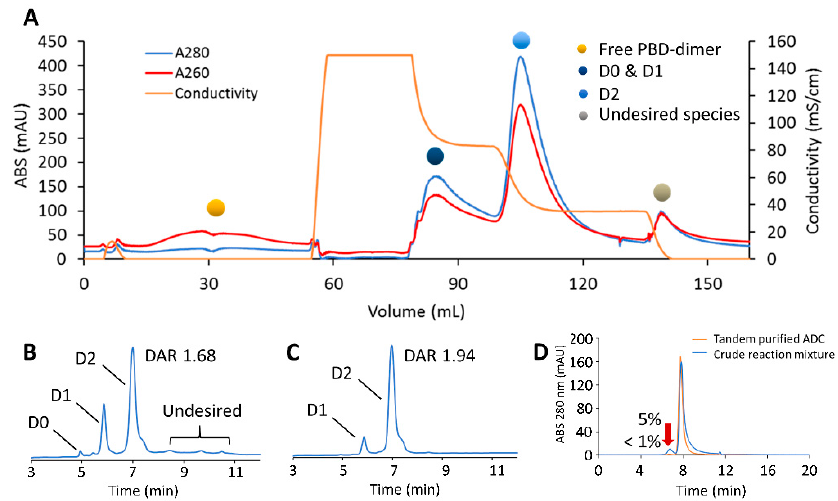
Figure 8. Tandem-model purification of the crude mAb-PBD dimer conjugate. ( A ) Purification of engineered Cysteine-mAb-PBD ADC in the tandem model. The quenched reaction mixture was loaded to Sartobind ® S that was tandemly connected to Sartobind ® Phenyl. The conjugation species were separated through loading, washing, and multiple elution steps. ( B ) HIC profile showing that the crude reaction mixture contains ADC variants with a range of DAR, residual linker-PBD, aggregates, and organic solvent. ( C ) HIC profile of the tandem method-purified ADC. The DAR of the ADC increased from 1.68 to 1.94. ( D ) SEC profile showing the percentage of aggregate dropped from 5% to less than 1% after tandem-model purification.